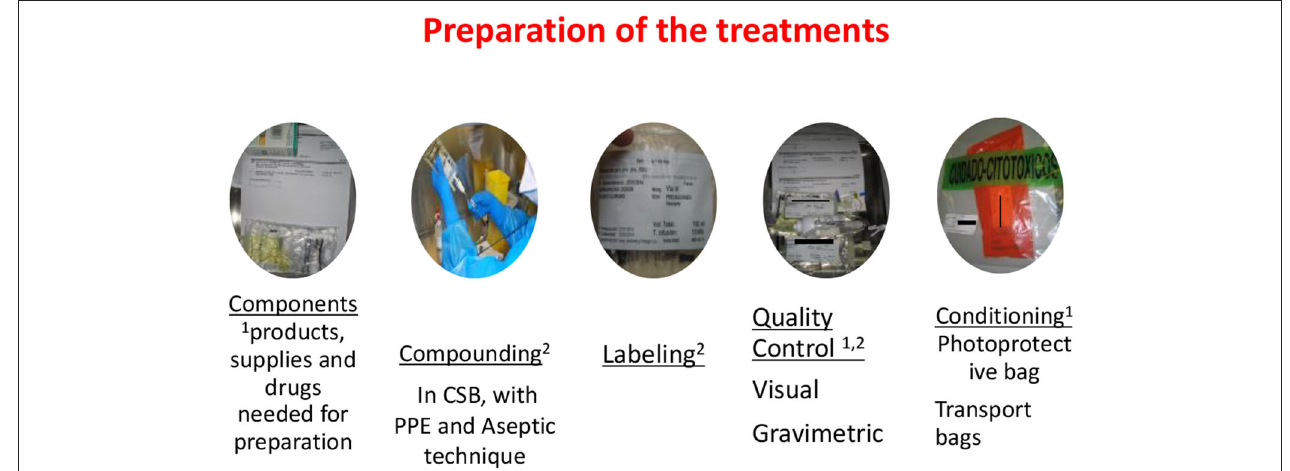
FIGURE 3 | Preparation of the treatments: (1) Pharmacy technician (2) Pharmacy nurse.